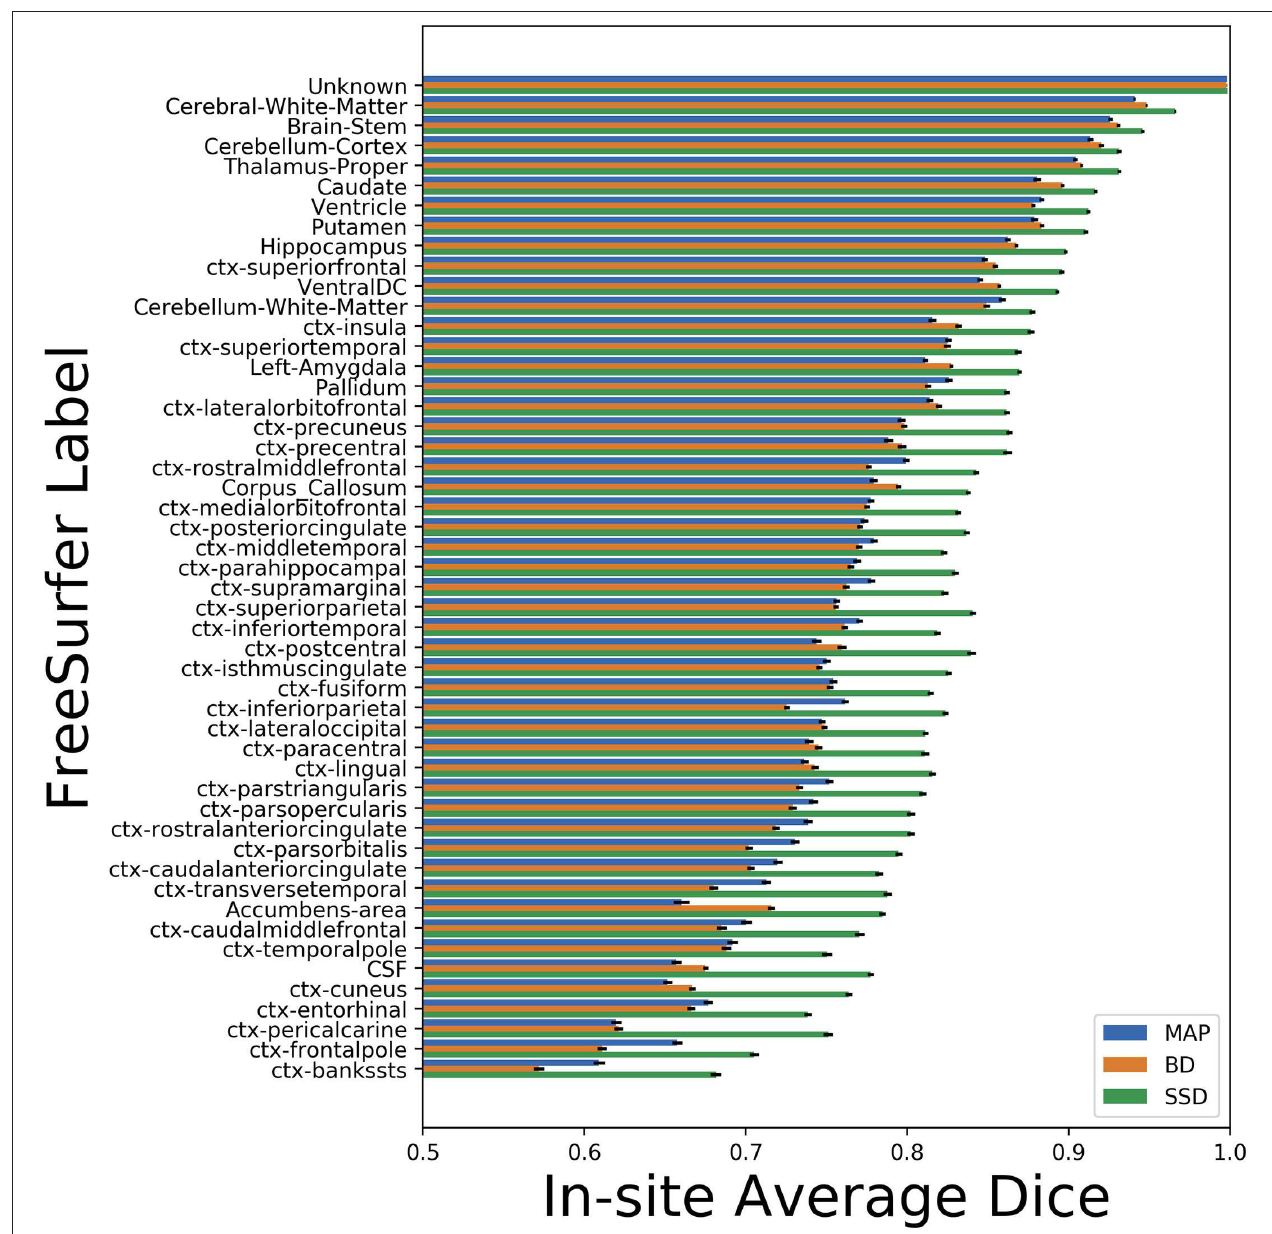
FIGURE 2 | Average Dice scores, sorted in decreasing order by average method performance, and standard errors across in-site test volumes for each label for the maximum a posteriori (MAP), MC Bernoulli dropout (BD), and spike-and-slab dropout (SSD)